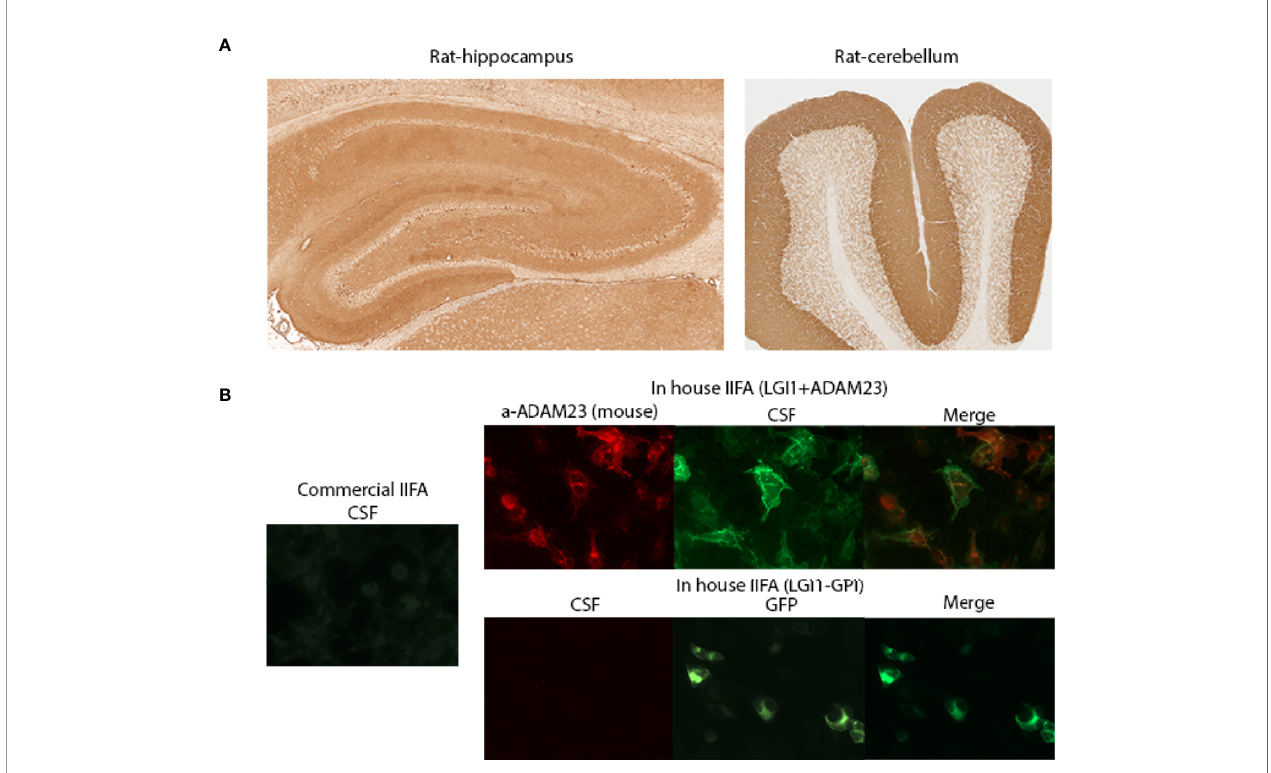
FIGURE 3 | Discrepancies identifying LGI1 antibodies by IIFA. (A) A patient ’ s CSF demonstrating LGI1 immunoreactivity on rat brain immunohistochemistry. Hippocampus (left panel) and cerebellum (right panel) staining patterns. (B) Left panel shows patient ’ s CSF reactivity on commercial IIFA LGI1 transfected cells (negative staining); Right panels show CSF reactivity on in-house IIFAs using LGI1 plus ADAM23 transfected cells (upper panels; positive staining) and GPI-LGI1 transfected cells (lower panels, negative staining). GPI: glycosyl-phosphatidylinositol anchored LGI1 (to display the protein on the cell surface).